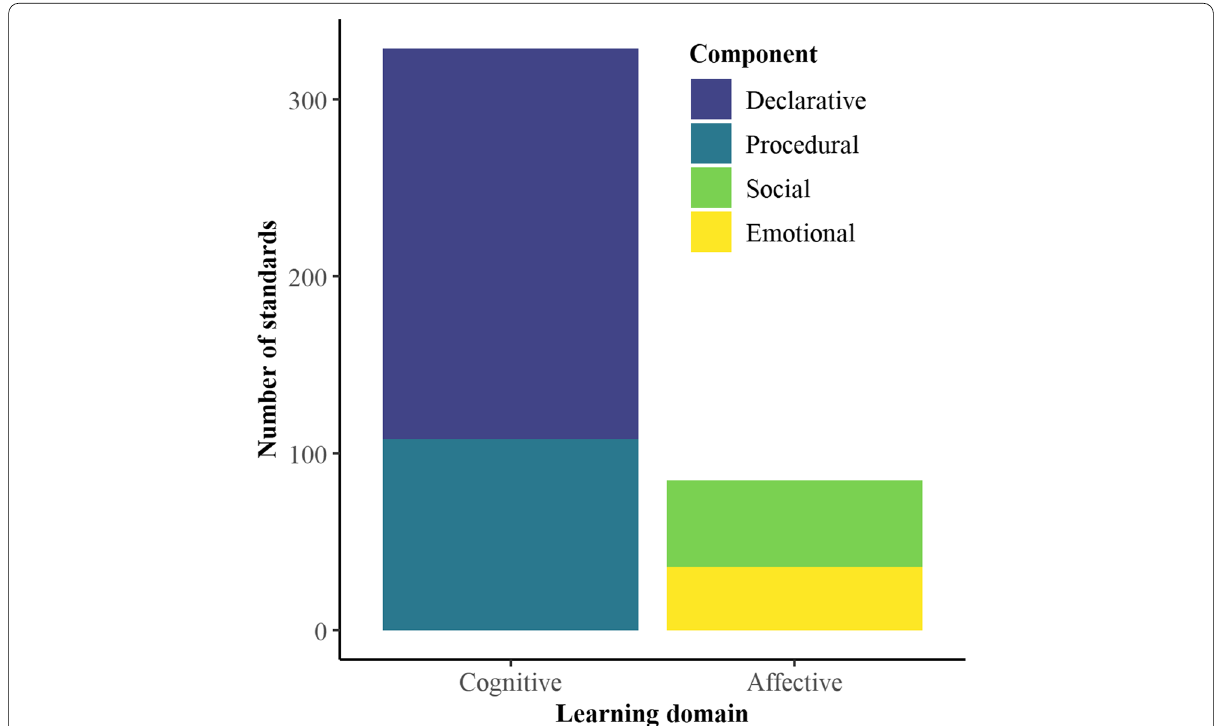
Fig. 3 Learning domains of water